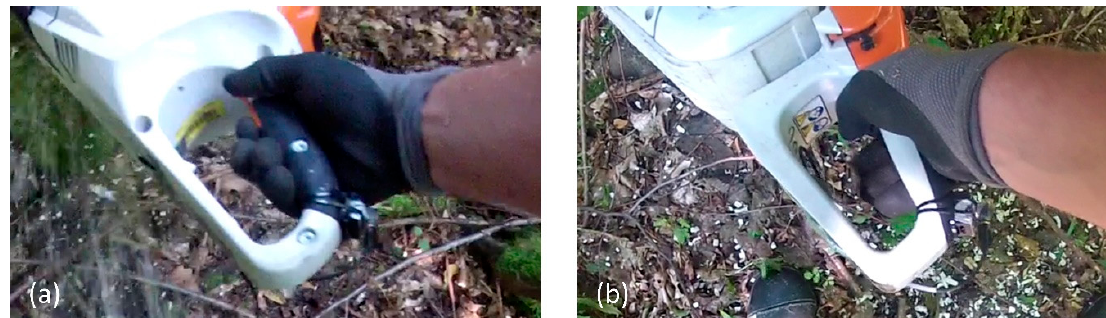
Figure 5. Hand position on the rear handle ( a ) of the MSA 220 C and ( b ) the MS 201 C while sawing.